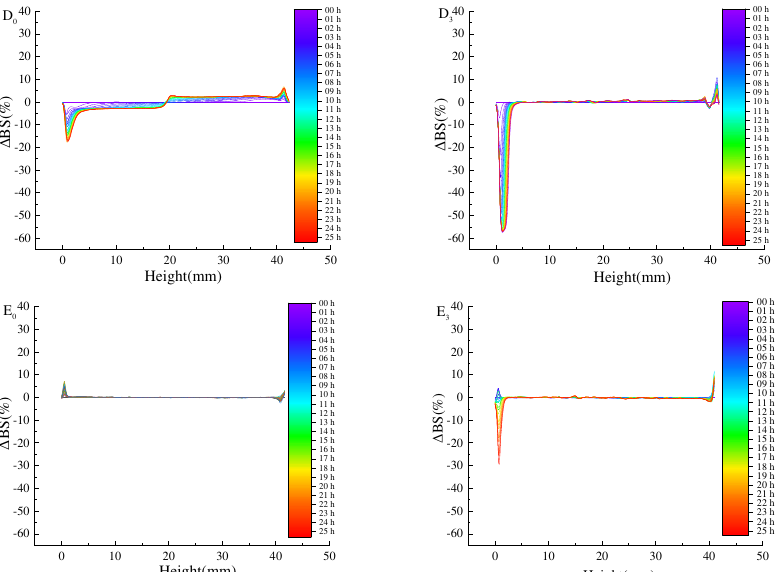
Figure 6. Shows the change of ∆ BS of the Pickering emulsion formed by different oil phase volume fractions under the condition of particle concentration 35 mg/mL and after freeze–thaw treatment. (The details are the same as the notes in Figure 5. ( A 0 ) 10% initial Pickering emulsion, ( B 0 ) 20% initial Pickering emulsion, ( C 0 ) 30% initial Pickering emulsion, ( D 0 ) 40% initial Pickering emulsion, ( E 0 ) 50% initial Pickering emulsion, ( A 3 ) 10% Pickering emulsion with three freeze-thaw cycles, ( B 3 ) 20% Pickering emulsion with three freeze-thaw cycles, ( C 3 ) 30% Pickering emulsion with three freeze-thaw cycles, ( D 3 ) 40% Pickering emulsion with three freeze-thaw cycles, ( E 3 ) 50% Pickering emulsion with three freeze-thaw